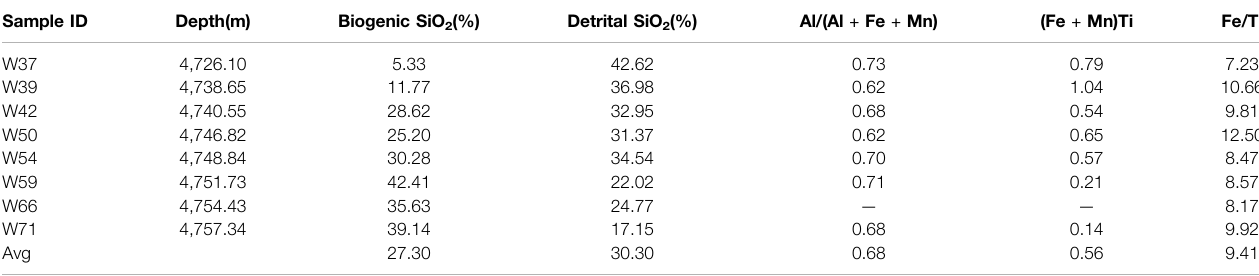
TABLE 2 | The derived and geochemical parameters of the shale samples. Sample